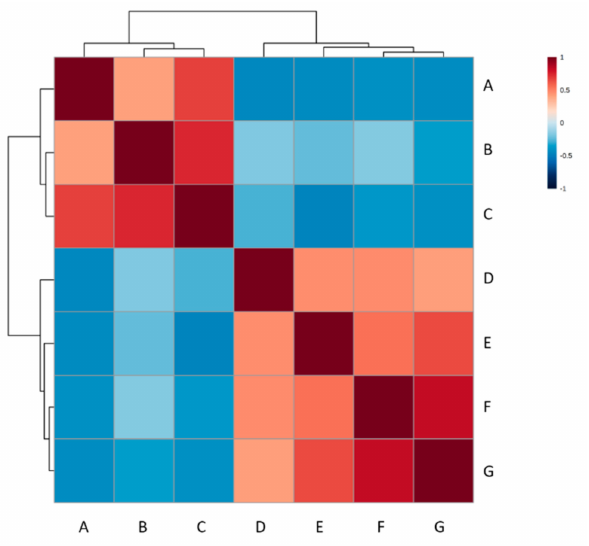
Figure 5. A heatmap of the Pearson’s correlation coefficients produced by comparing liveweight (kg) at 3.0 months of age and metabolites significantly affected by time between 2 weeks and 3 months of age, whereby − 0.4 < correlation co-efficient > 0.4. Positive cor- relations are shown in red; negative correlations are shown in blue. A = liveweight (kg), B = 3-phenylpropionate, C = acetic acid, D = dehydroisoandrosterone 3-glucuronide, E = hydrox- ypropionic acid, F = 13-L − Hydroperoxylinoleic acid, G = docosapentaenoic